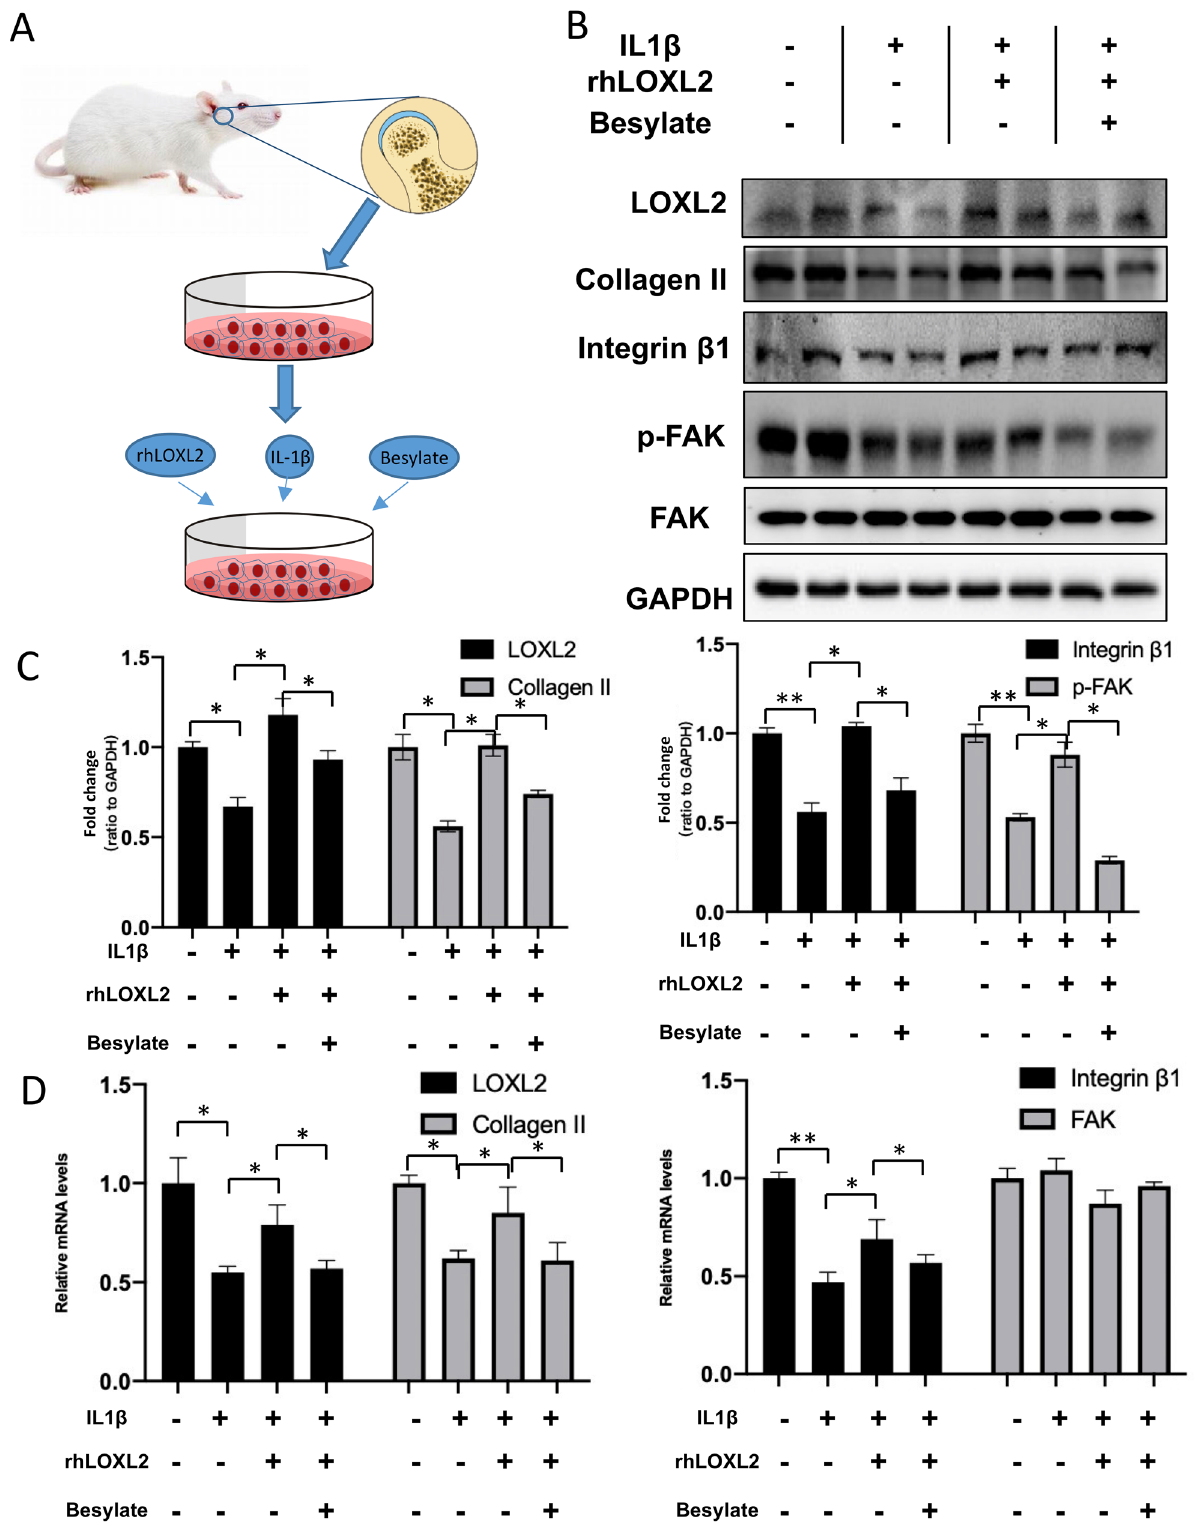
Figure 6. LOXL2 restored IL-1β-mediated Collagen II degradation through Integrin/FAK pathway. ( A ) Flow chart of the isolation of TMJ chondrocytes and schematic diagram of agent-treated chondrocytes. ( B ) Western blot analysis and ( C ) quantitative results of LOXL2, Collagen II, Integrin β1, p-FAK and FAK expression in chondrocytes from samples treated as indicated. ( D ) RT-qPCR analysis of LOXL2, Collagen II, Integrin β1 and FAK expression in chondrocytes from samples treated as indicated. Error bars represent S.D. *P < 0.05, **P <